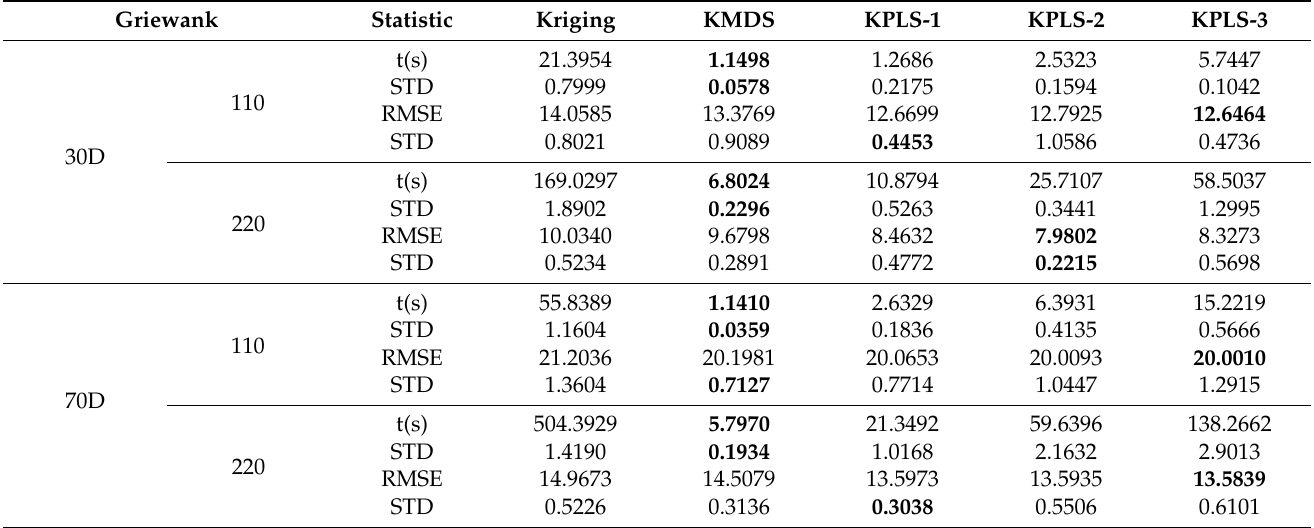
Table 3. Results for time and RMSE for Griewank function. The symbols 30D and 70D indicate that the dimensions of benchmark functions are 30 and 70,